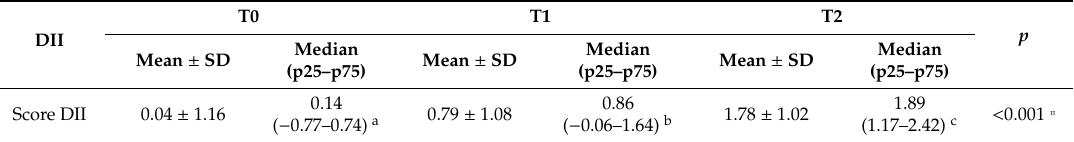
Table 4. Dietary Inflammatory Index (DII) by time of chemotherapy of women with breast cancer at a